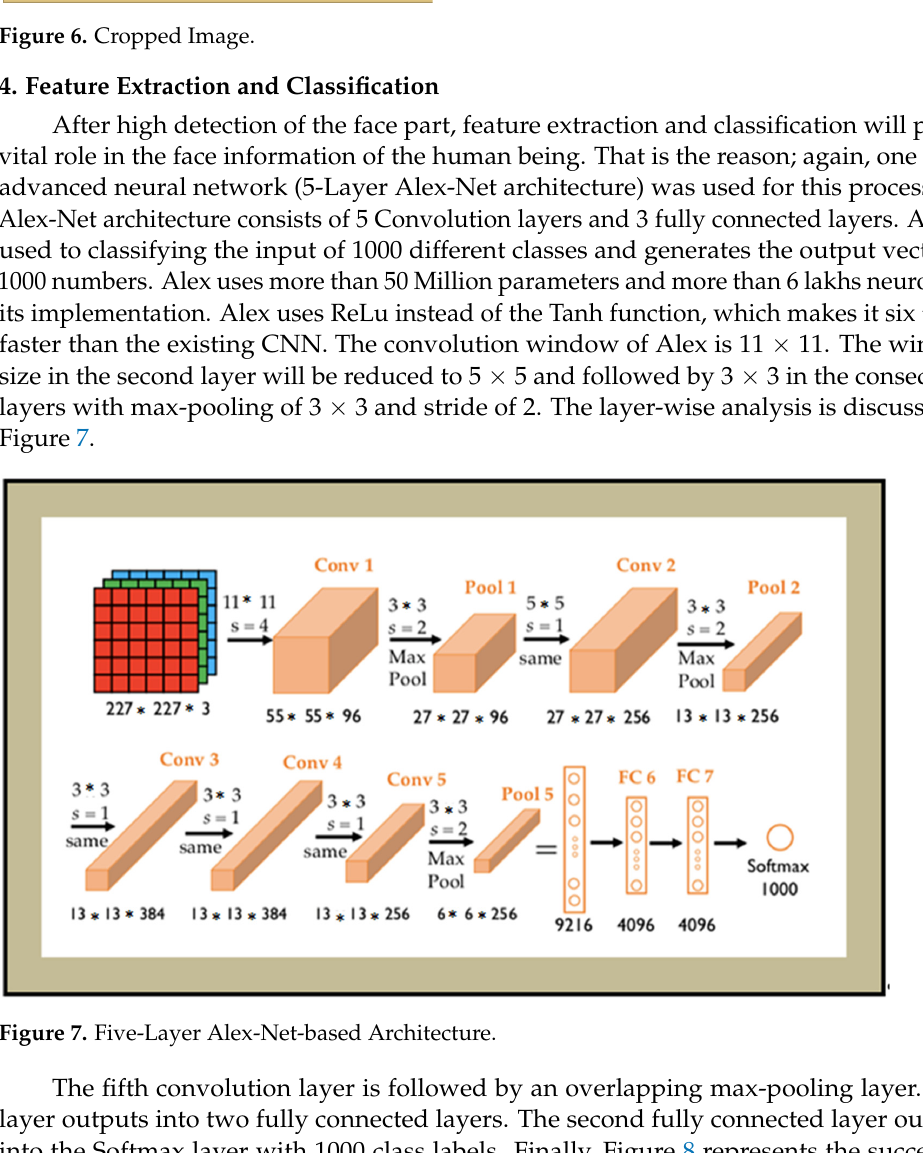
Figure 6. Cropped Image.